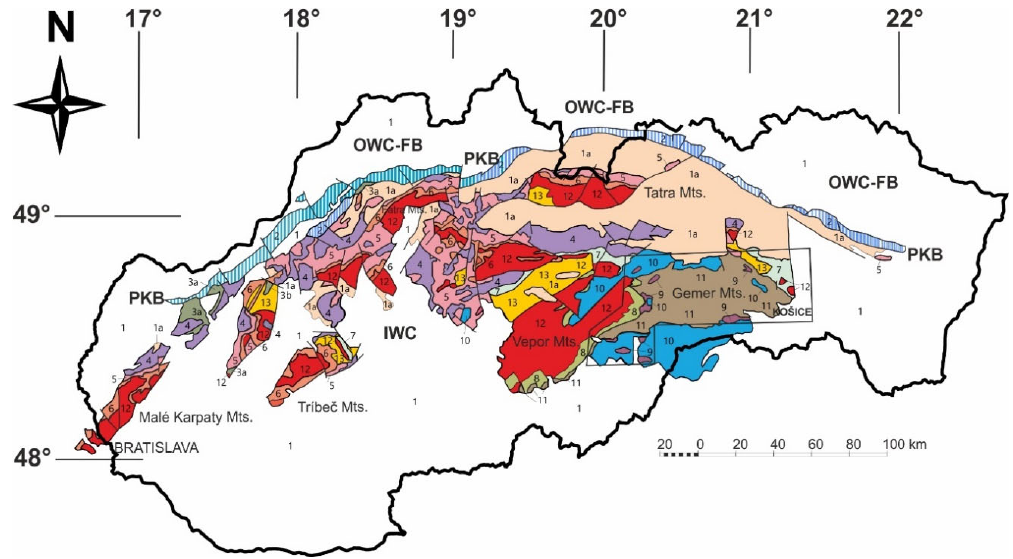
Figure 1. Schematic tectonic map of the Inner Western Carpathians (IWC, modified from [18]). 1— Quaternary and Cenozoic deposits undivided; Outer Western Carpathians Flysch Belt (OWC ‐ FB);